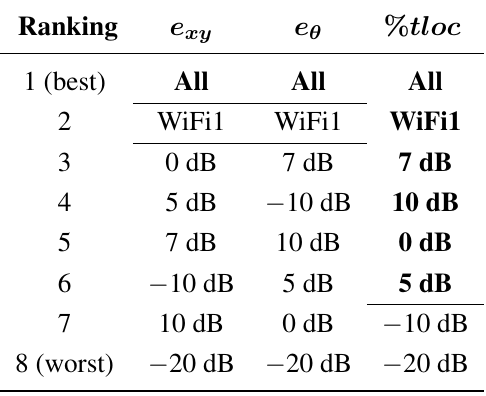
Table 2. Ranking of the second experiment according to different statistical measurements using the Friedman aligned ranks method [41] ( p -value = 0.05). We highlight in boldface the winning configuration. We separate configurations with horizontal rows when there is a significant different among them ( post hoc Holm test [41] with α = 0.05). These statistical tests were performed using the STAC web tool [42]. We have analyzed the performance of the algorithm using the motes with different transmission powers (tagged as − 20 dBm, − 10 dBm, 0 dBm, 5 dBm, 7 dBm and 10 dBm), with varying transmission power (tagged as ‘all’) and with the best WiFi card of the previous experiment (tagged as WiFi1). We have discarded the results obtained when using a transmission power of − 40 dBm (because the algorithm did not converge most of the times) and − 30 dBm (because the algorithm did not converge